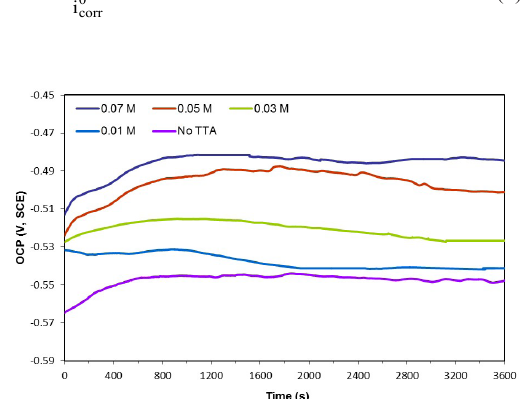
Figure 2. Open circuit potential of mild steel in 0.5 M HCl solution containing various concentrations of TTA (0 to 0.07 M) at 293 K after 3600s immersion.